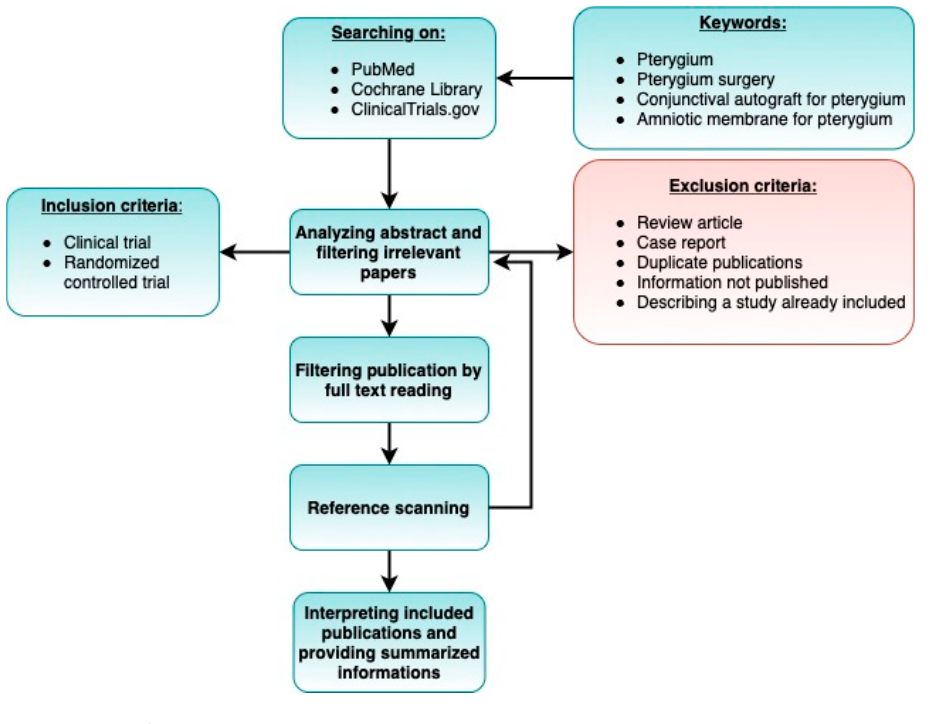
Figure 1. Search